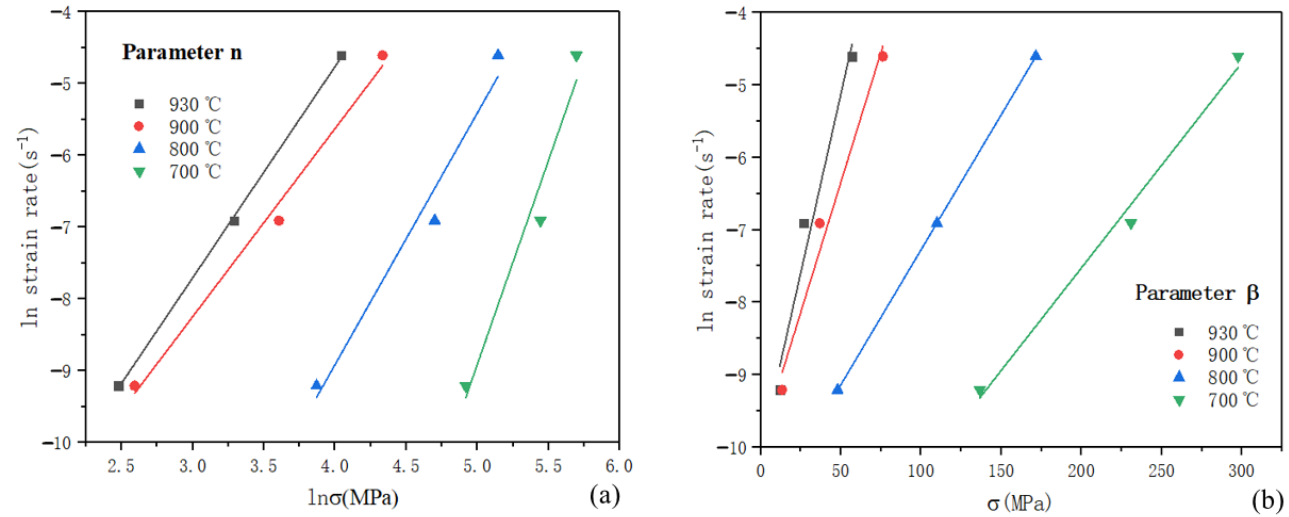
. . and ln , and ( b ) ln and . ε and ln σ , and ( b ) ln ε and σ . ε̇ ε̇ 𝜎𝜎 𝜎𝜎